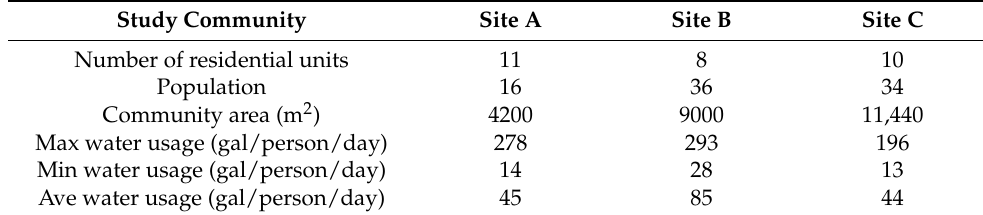
Table 1. Data summary of the studied communities. Study